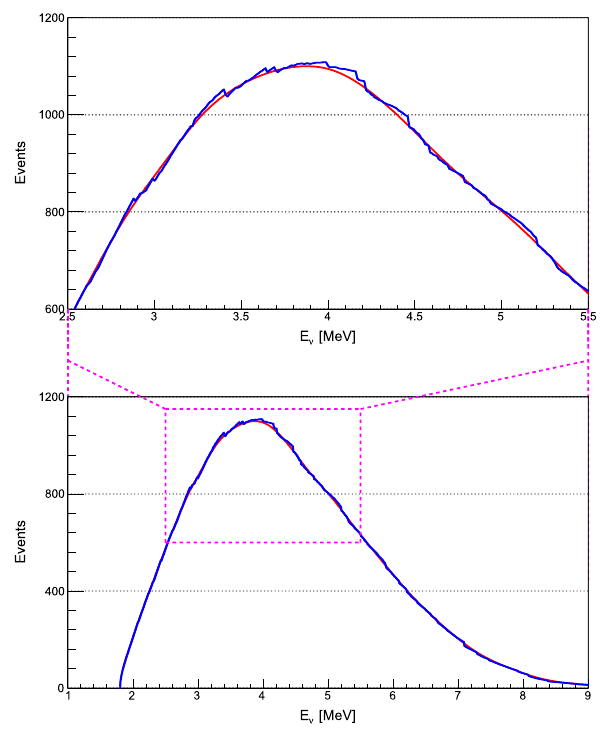
Fig. 2 Comparison of “the (un-oscillated) spectrum with fine struc- ture” to the “smooth (un-oscillated) spectrum after smearing”. The red curve corresponds to the expected smooth spectrum (the smeared out spectrum with8%energyresolution). Theblue curveshows theoriginal jagged spectrum without smearing